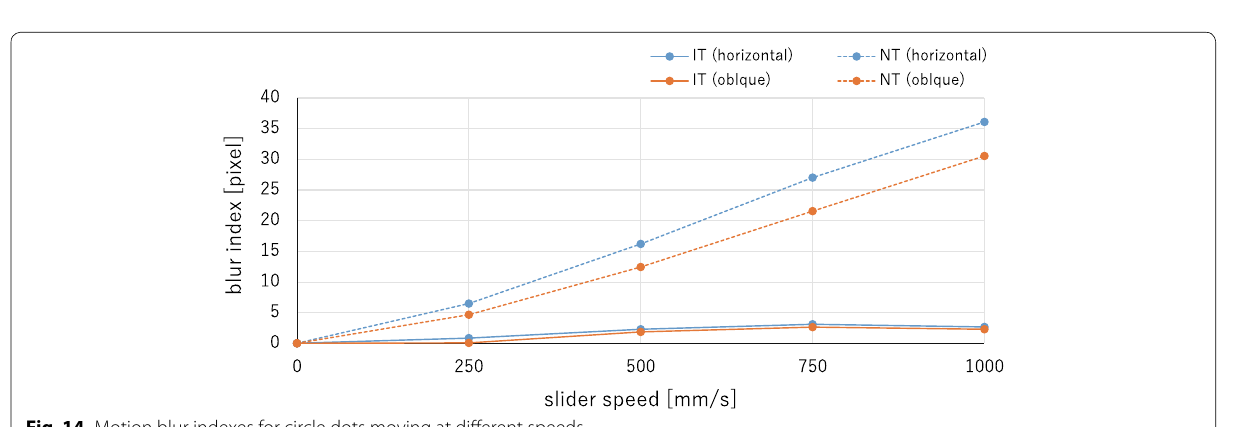
Fig. 14 Motion blur indexes for circle dots moving at different